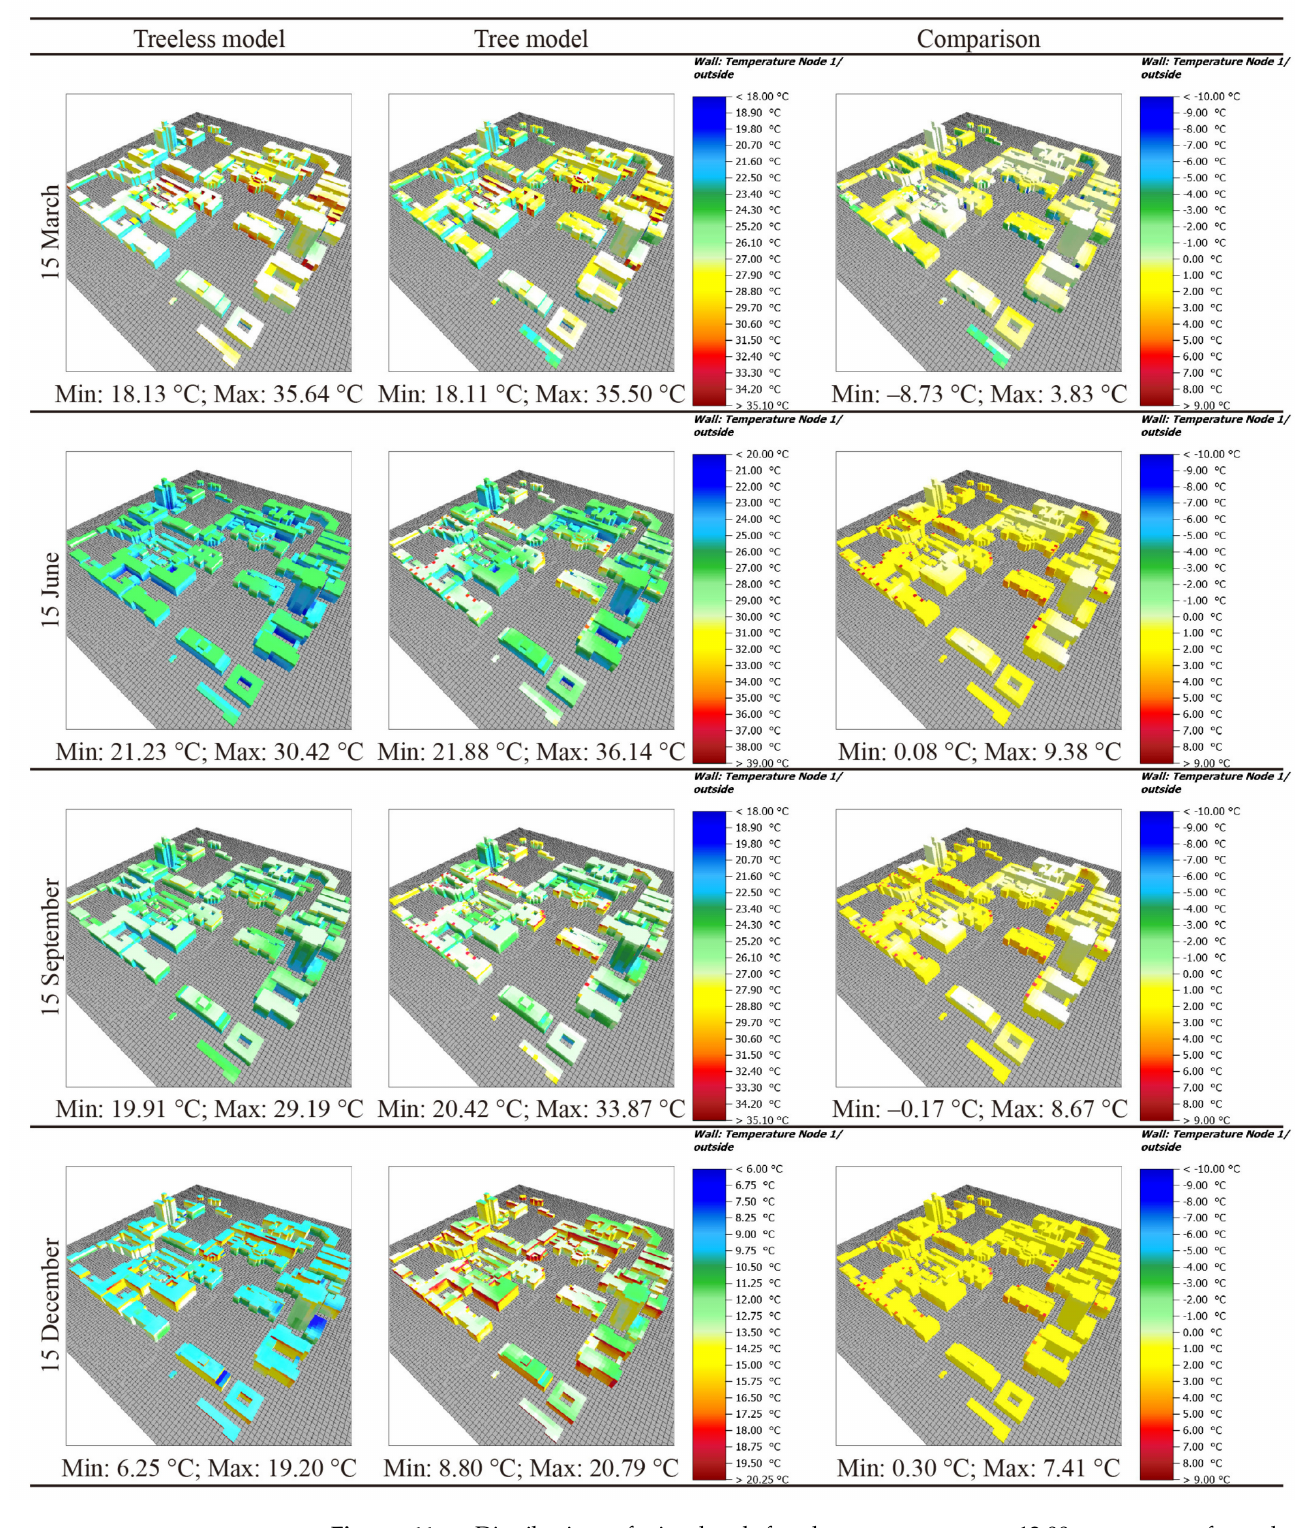
Figure 11. Distribution of simulated façade temperature at 12:00 p.m. on four days. (Comparison = Tree model simulation minus treeless model